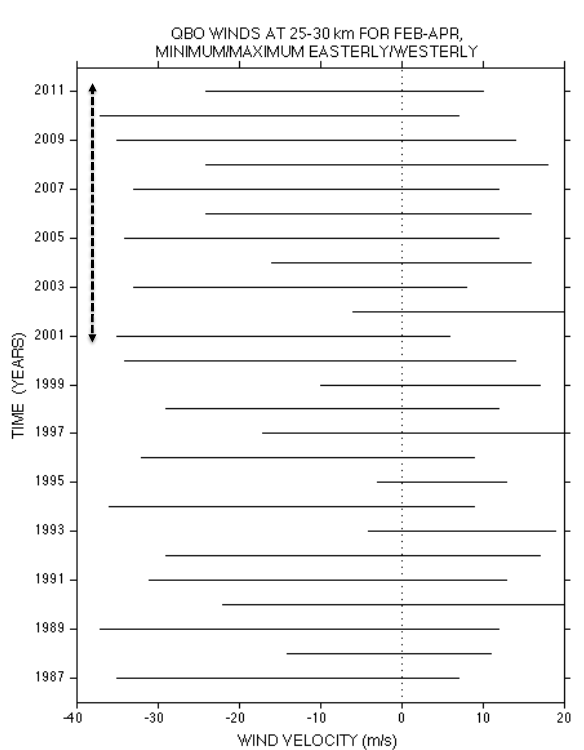
Fig. 8. The strongest eastward and westward QBO wind data at 25– 30km for February to April from 1987 to 2011 for the months of strongest eastward and westward QBO wind data at 25 – 30 km for February to Fig. 8. The February–April. The dashed line shows duration of the zonal winds April from 1987 – 2011 for the months of February – April. The dashed line shows duration of observed by the Ascension Island the zonal winds observed by the Ascension Island radar.